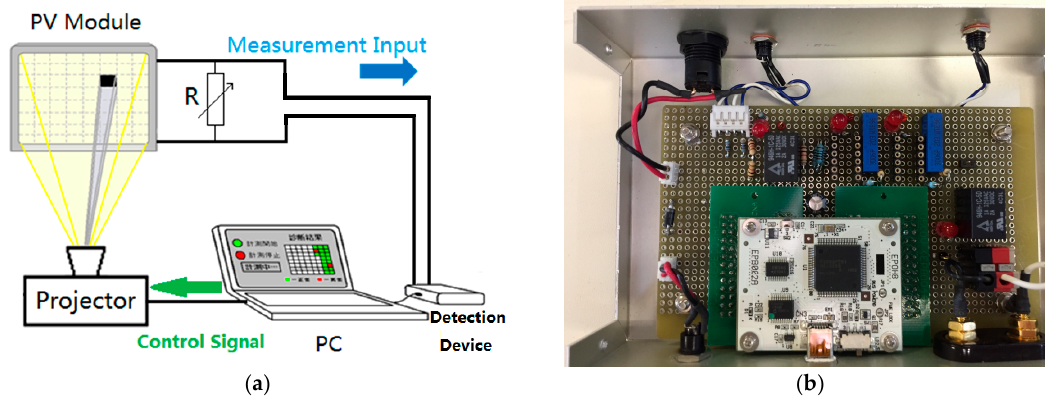
Figure 12. Voltage-based detection system: ( a ) Configuration of voltage-based hot-spot detection system, which consists of a projector part and measurement part; ( b ) Prototype of the detection device. Energies 2017 , 10 , 230